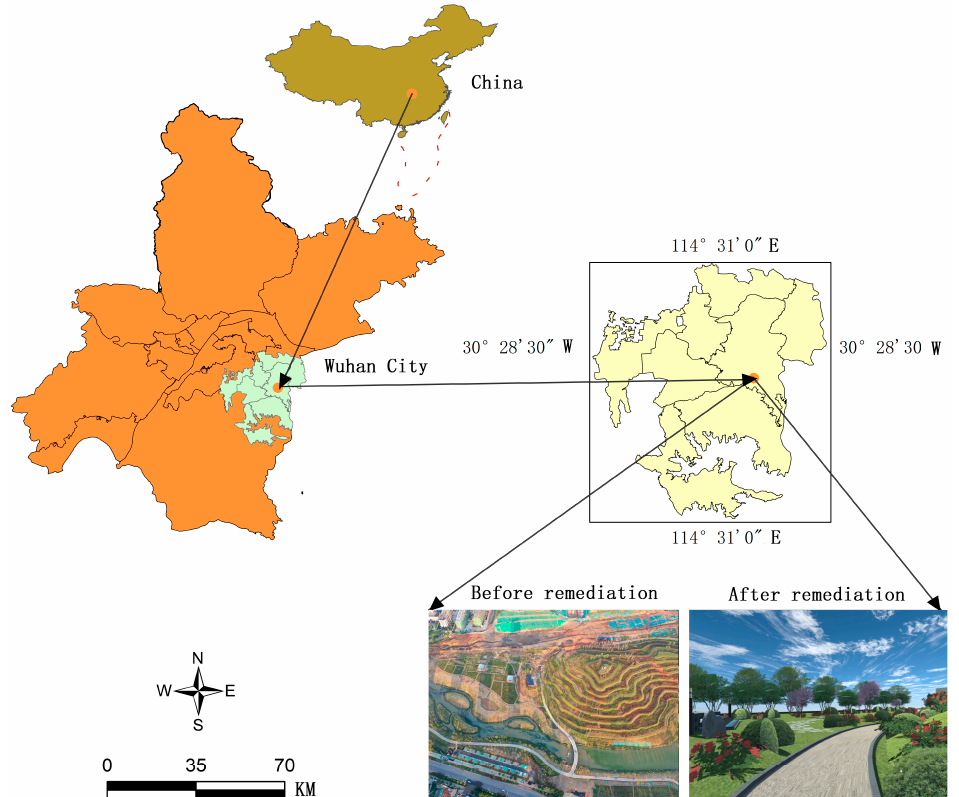
Figure 1. Location overview diagram of Baozixi eco-corridor in the high-tech zone. source: shot by DJI inspire 2 (DJI Technology Co., Ltd, Shenzhen, China).